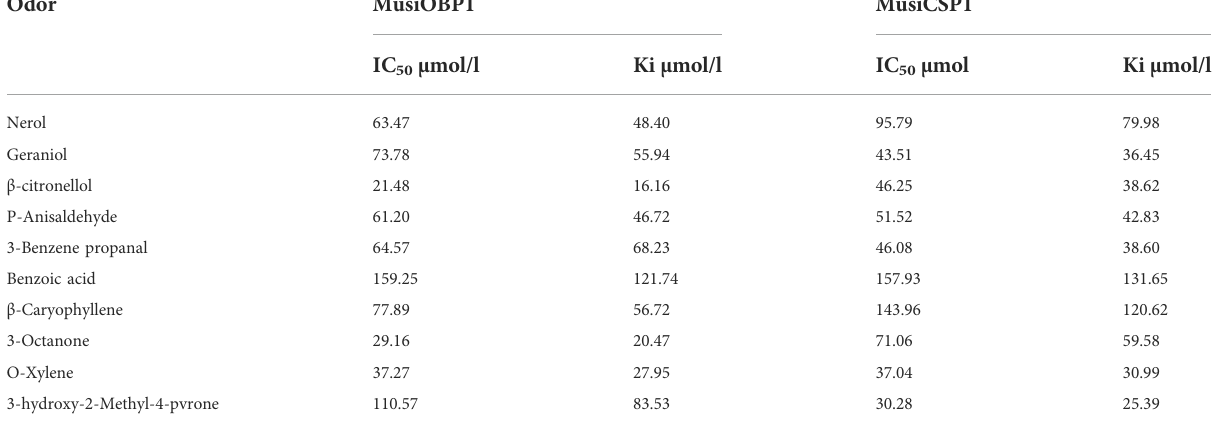
TABLE 2 Binding characteristics between protein and volatile